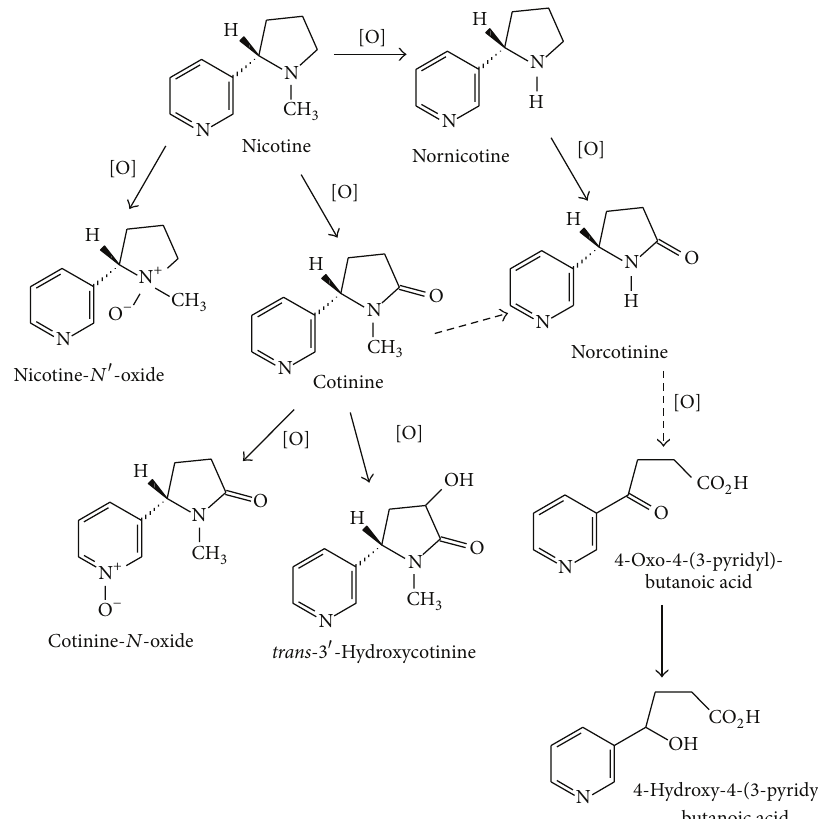
Figure 5: Pathways establishment of nicotine metabolism in electrodeless electrochemical oxidation (EEO) method coupled with UHPLC